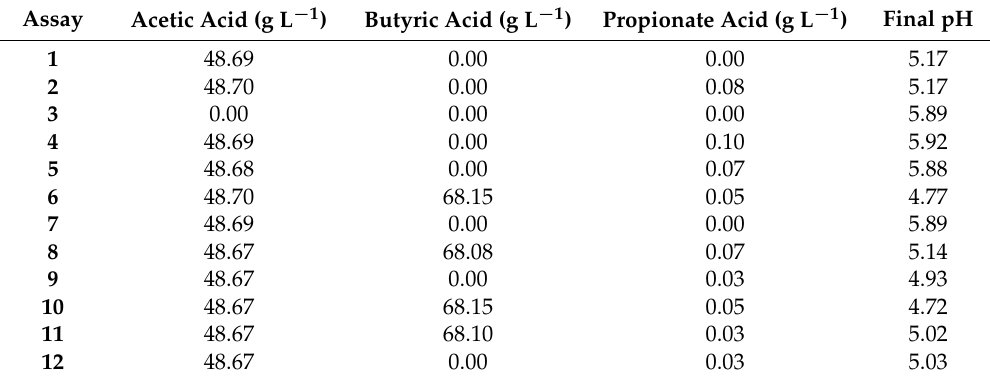
Table 5. Parameters of experimental assays for producing hydrogen: Combinations of substrates (crude glycerol and swine manure), volatile fatty acids, hydrogen yields, and final pH. Assay Acetic Acid (g L − 1 ) Butyric Acid (g L − 1 ) Propionate Acid (g L − 1